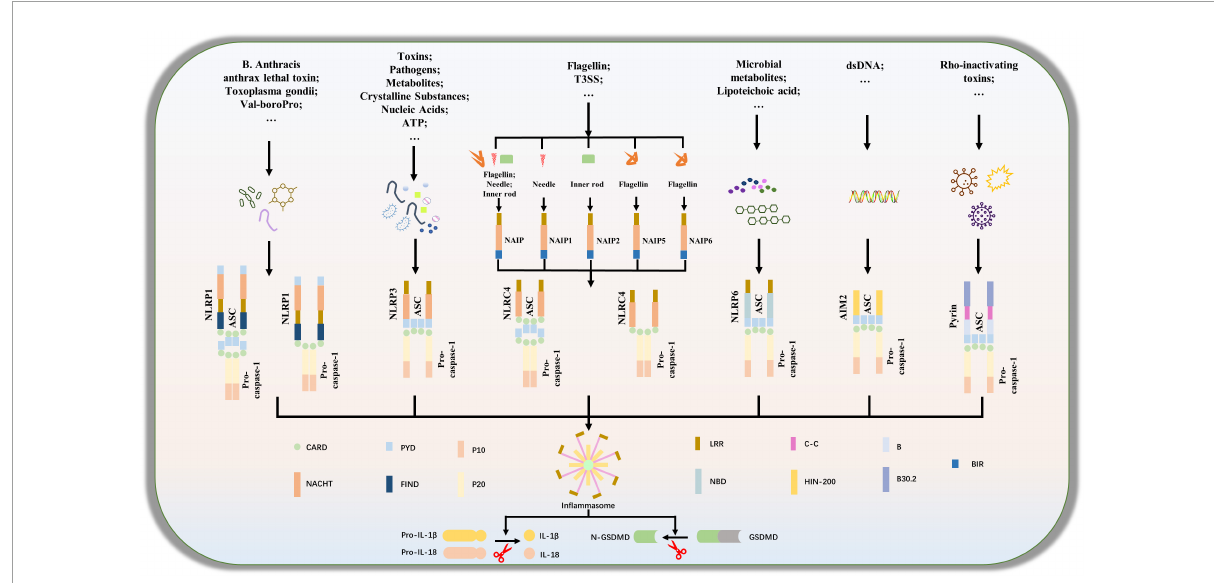
FIGURE1 Composition of inflammasome complexes. A subset of NOD-like receptors (NLRs), Nlrp1,Nlrp3, Nlrp6 and Nlrc4, as well as the cytosolic DNA sensor absent in melanoma 2, AIM2 and the protein product of Mediterranean fever (MEFV), Pyrin is known to engage well-defined inflammasomes to which caspase-1 is recruited directly or through the adaptor protein apoptosis-associated speck-like protein containing a CARD (ASC).